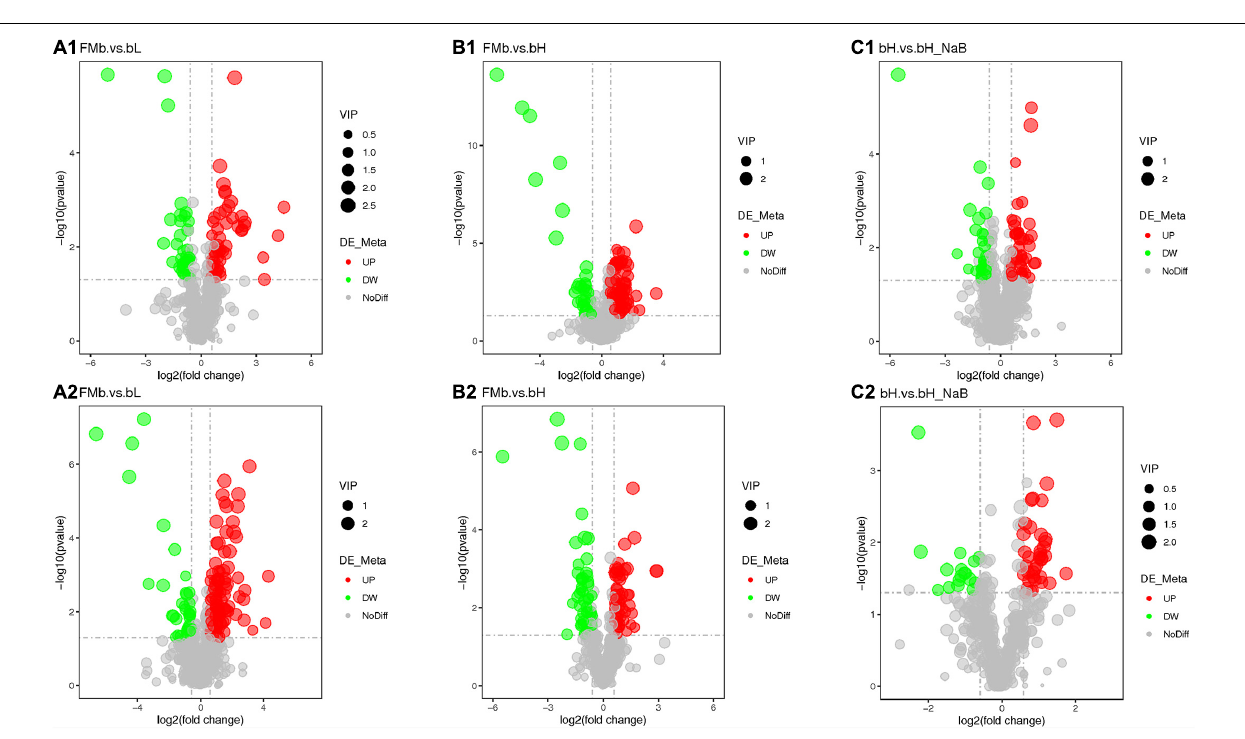
FIGURE 5 | Volcano plots of the DEGs in the distal intestine of hybrid grouper at different comparison objects. FMb vs. bL: positive (A1) and negative (A2) ions; FMb vs. bH: positive (B1) and negative (B2) ions; bH vs. bHNaB: positive (C1) and negative (C2)